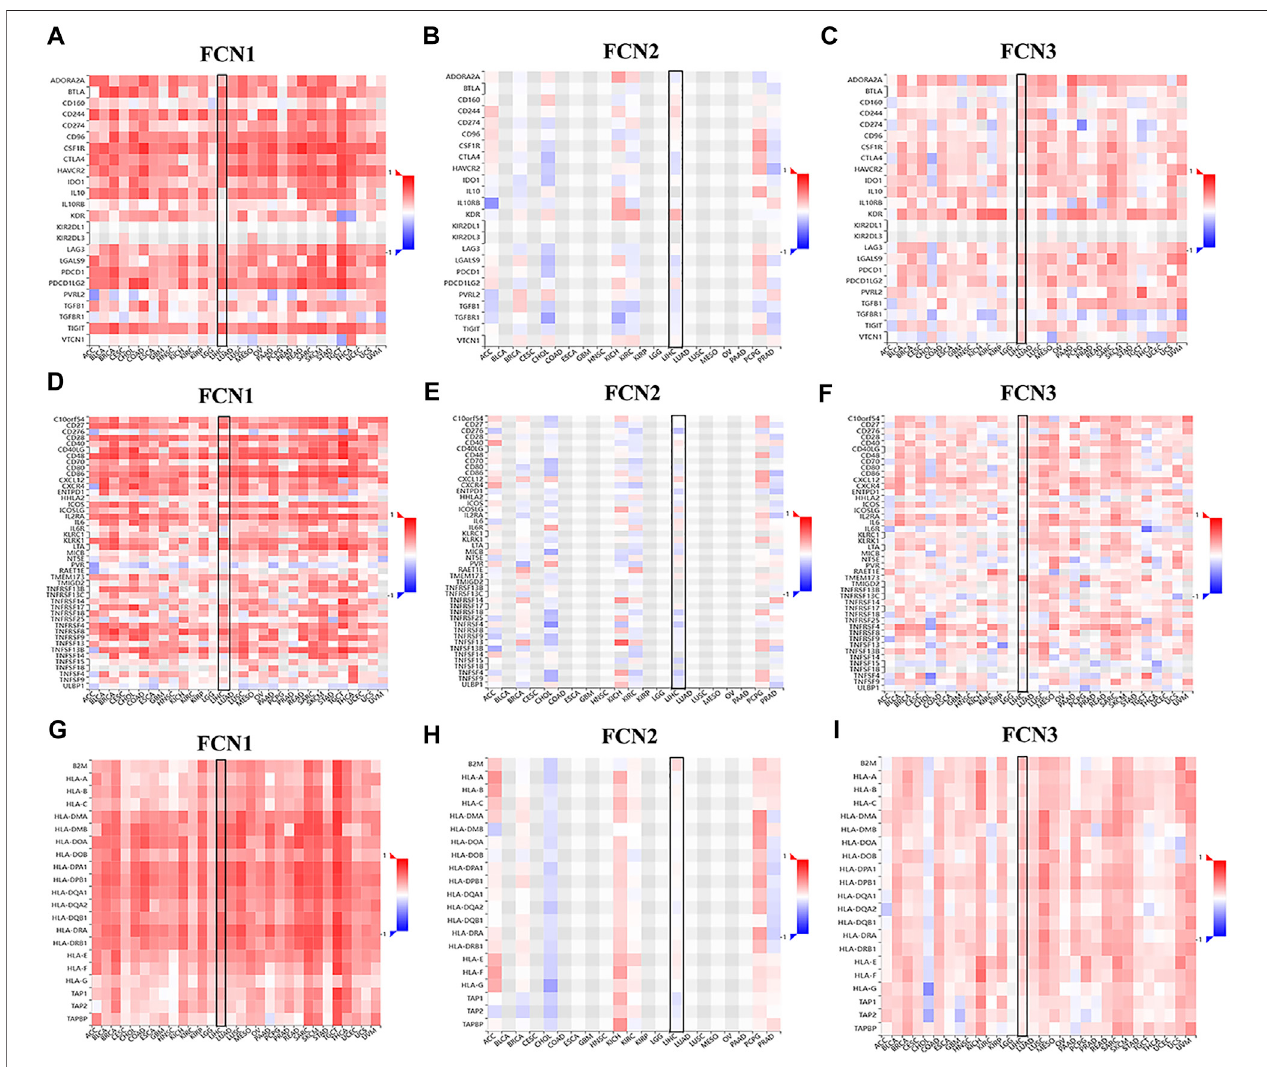
FIGURE 8 | Correlation analysis between FCNs expresion and immunoinhibitors, immunostimulators and majorhistocompatibility complex (MHCs). (A – C) Correlation analysis between FCNs expresion and immunoinhibitors (D – F) Correlation analysis between FCNs expresion and immunostimulators. (G – I) Correlation analysis between FCNs expresion and